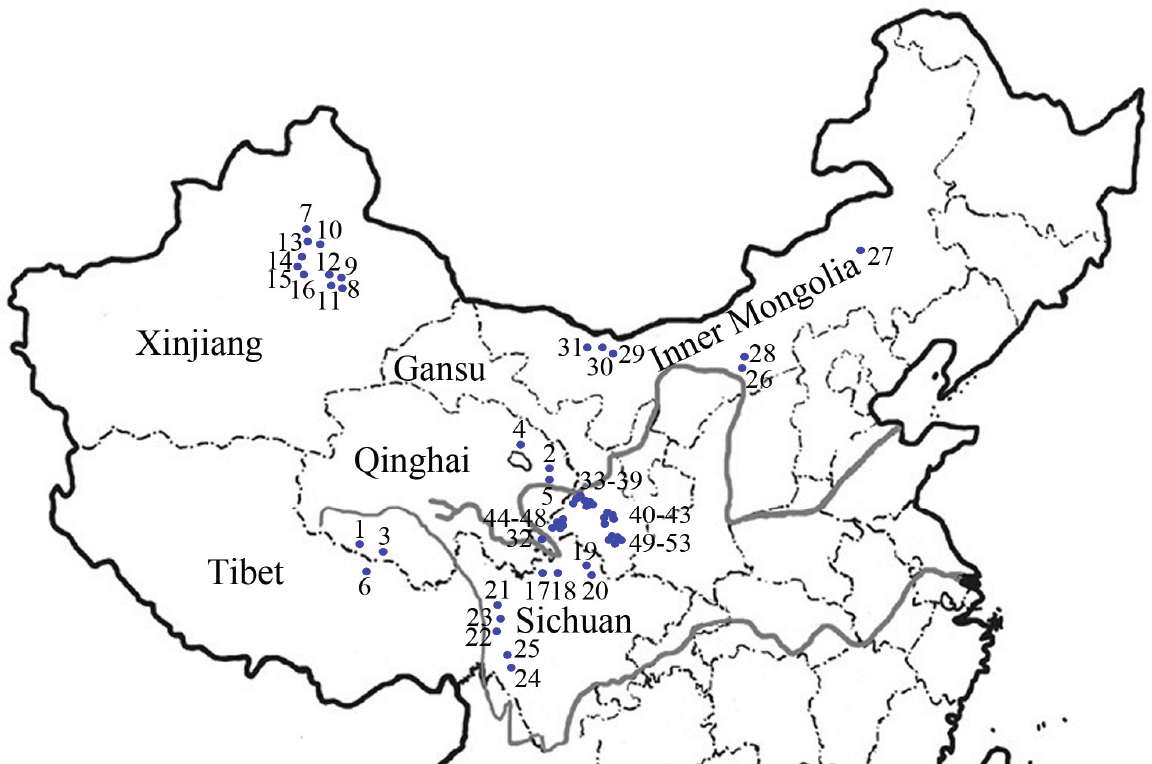
Figure 1. The geographic distribution of materials used in the